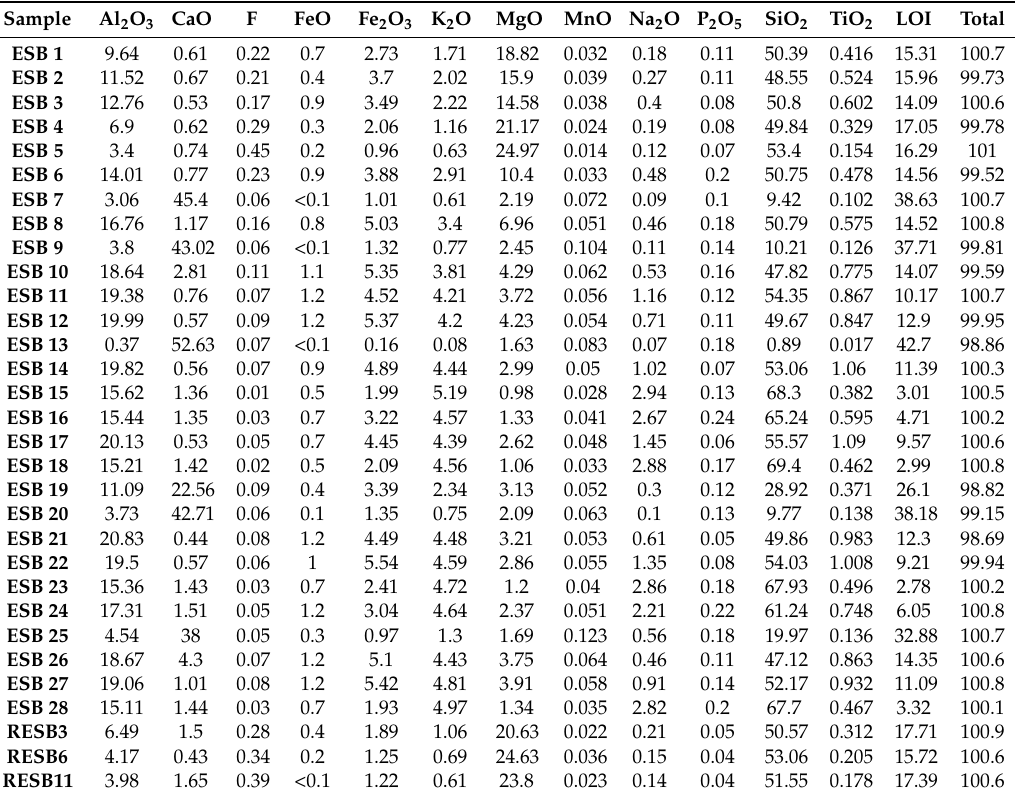
Table 2. Weight percentage (wt %) of major